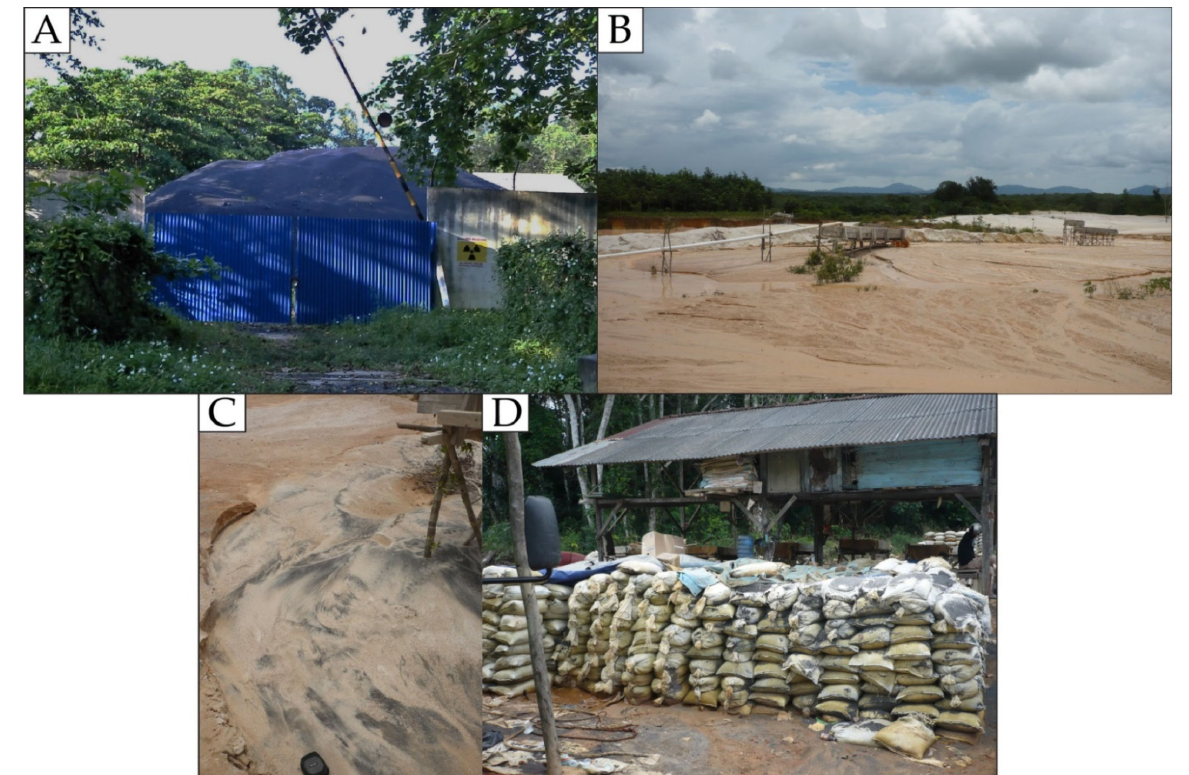
Figure 3. Tailings on Bangka Island; ( A ) state-owned tailings dump with warnings indicating radiation hazard; ( B ) illegal mining pit with pumps and tubs for washing cassiterite-enriched clastic sediments; ( C ) tailing resulting from processing and washing of cassiterite sands. By-product used to fill the pit; ( D ) jute bags of tailing in a domestic dump at a mineral broker/seller